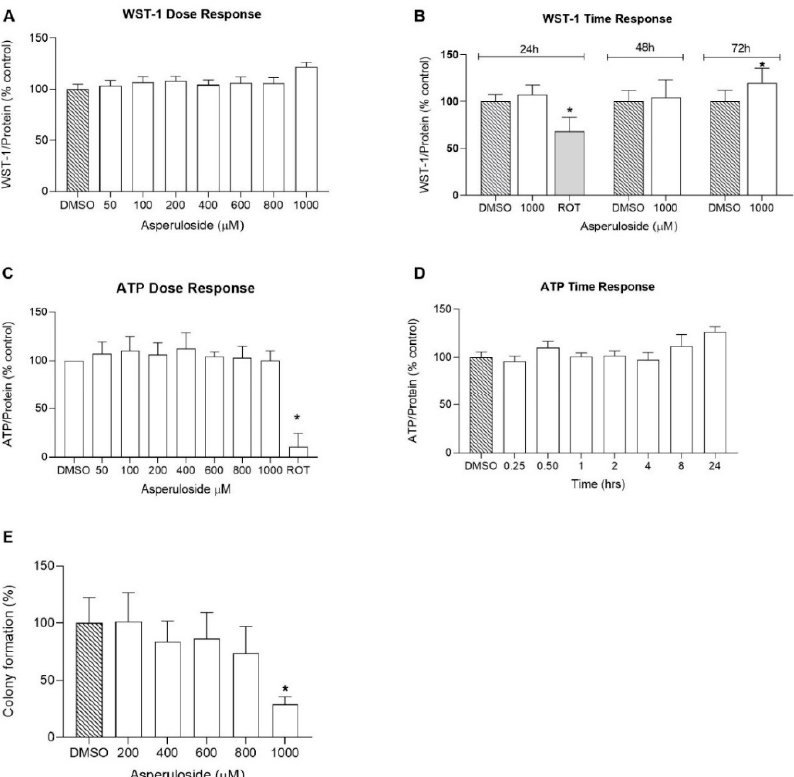
Figure 4. Doses and time-dependent in vitro cell viability and survival assays: ( A – D ) HepG2 cell culture viability was measured with WST-1 and ATP assays under varying concentrations of ASP and incubation periods in the presence of vehicle (DMSO). ATP activity was measured at 750 nm, while WST-1 absorbance was measured at 450 nm. Data are expressed as mean ± S.E. ( n = 6 wells per group). Data were analysed by one-way ANOVA followed by LSD test. * Significant effect ( p < 0.05). ( E ) Long-term cell viability was measured with colony forming assay using varying concentrations of ASP. Error bars show the S.E. for at least four independent experiments, and every drug concentration was added in four replicates ( n = 16). Data were analysed by one-way ANOVA followed by LSD test. * Significant effect ( p <